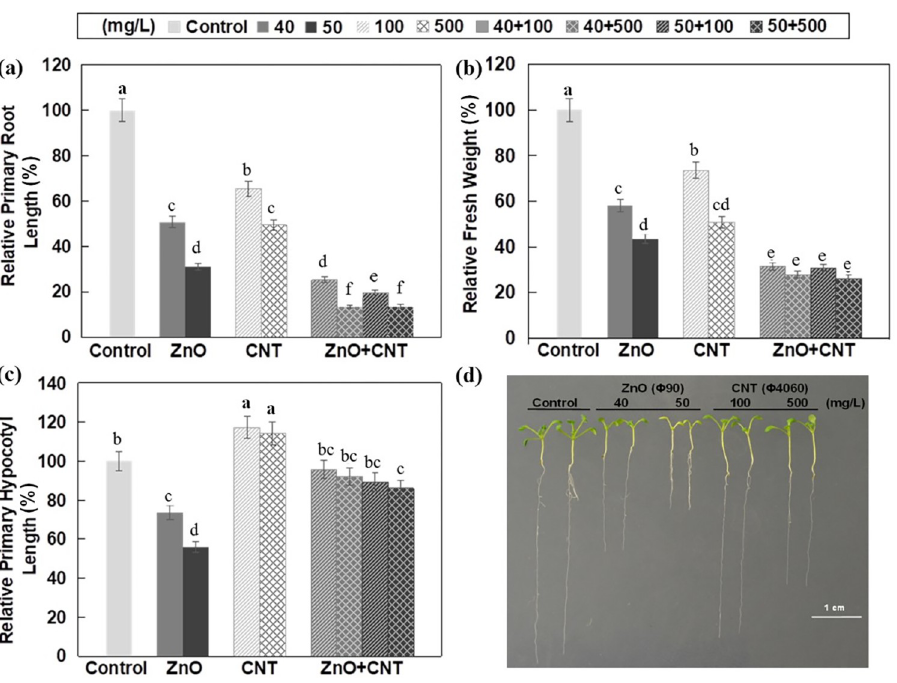
Fig 1. Effects of ZnO NPs and MWCNTs, alone or in combination, on Arabidopsis seedling growth at 10 DAG. (a) Relative primary root length. (b) Relative fresh weight. (c) Relative hypocotyl length. (d) Representative photographs of Arabidopsis seedlings. ½ MS Medium without NPs was used as control. Data are the means ± standard errors of three replicates. Different letters indicate a significant difference between treatments ( P < 0.05, Duncan test).